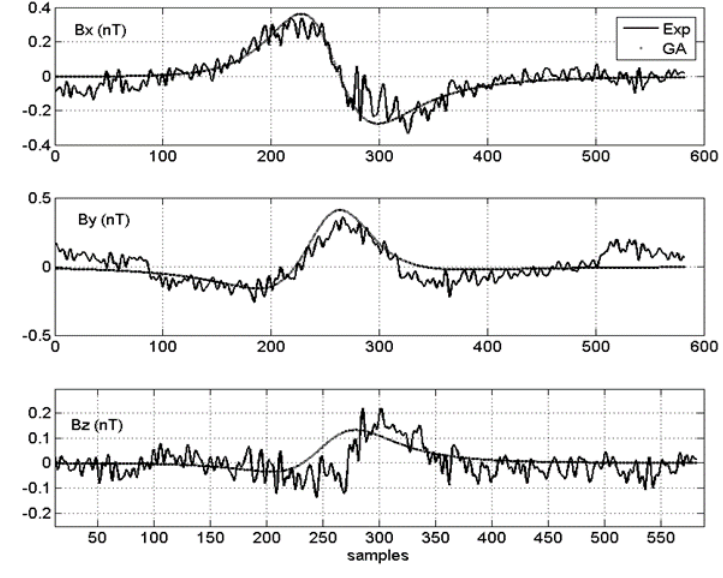
Figure 8. Noisy signal (Signal to noise ratio (SNR) 1): Experimental vs. GA